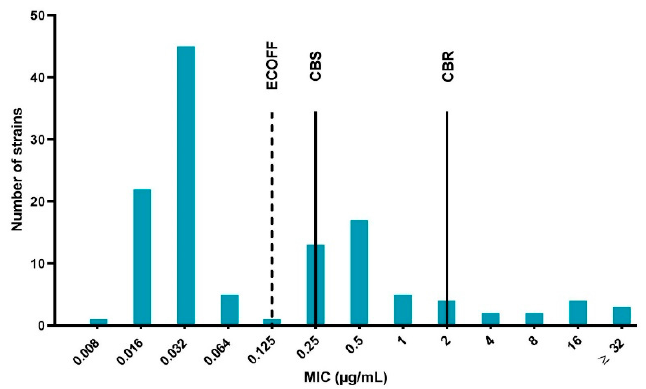
Figure 1. Enrofloxacin minimum inhibitory concentration (MIC) distribution of the 125 avian pathogenic Escherichia coli (APEC) strains isolated from broiler farms in Flanders with colibacillosis outbreaks. The dotted line represents the epidemiological cut-o ff (ECOFF), which is 0.125 µ g / mL. Strains with MIC values ≤ ECOFF are labeled wild type (WT) and strains with higher MIC values than the ECOFF as non-wild type (NWT). The full lines marked CBS and CBR indicate the clinical breakpoint for susceptibility (0.25 µ g / mL, CBS) and resistance (2 µ g / mL, CBR), respectively. Strains with MIC in between CBS and CBR are designated intermediate. Table 1. Summary of the mutant prevention concentration (MPC) values of 20 selected sensitive avian pathogenic Escherichia coli (APEC) strains obtained via agar dilution experiments performed in triplicate. The width of the mutant selection window (MSW), indicated by the MPC over the MIC ratio, is given between brackets next to the MPC